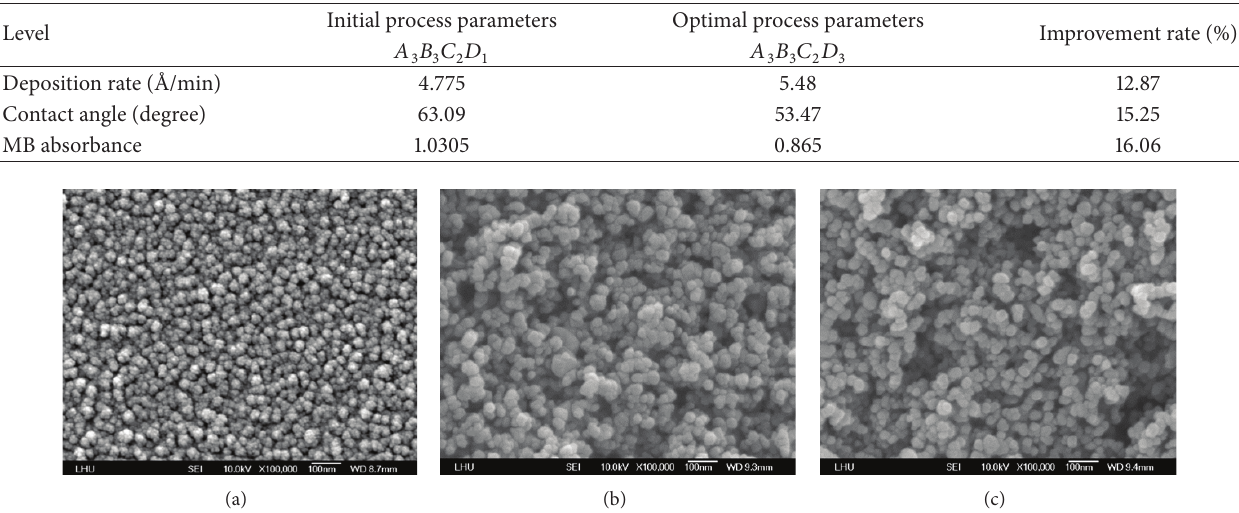
Table 5: The confirmation test results for the multiple performance characteristics, using the initial and the optimal process parameters.